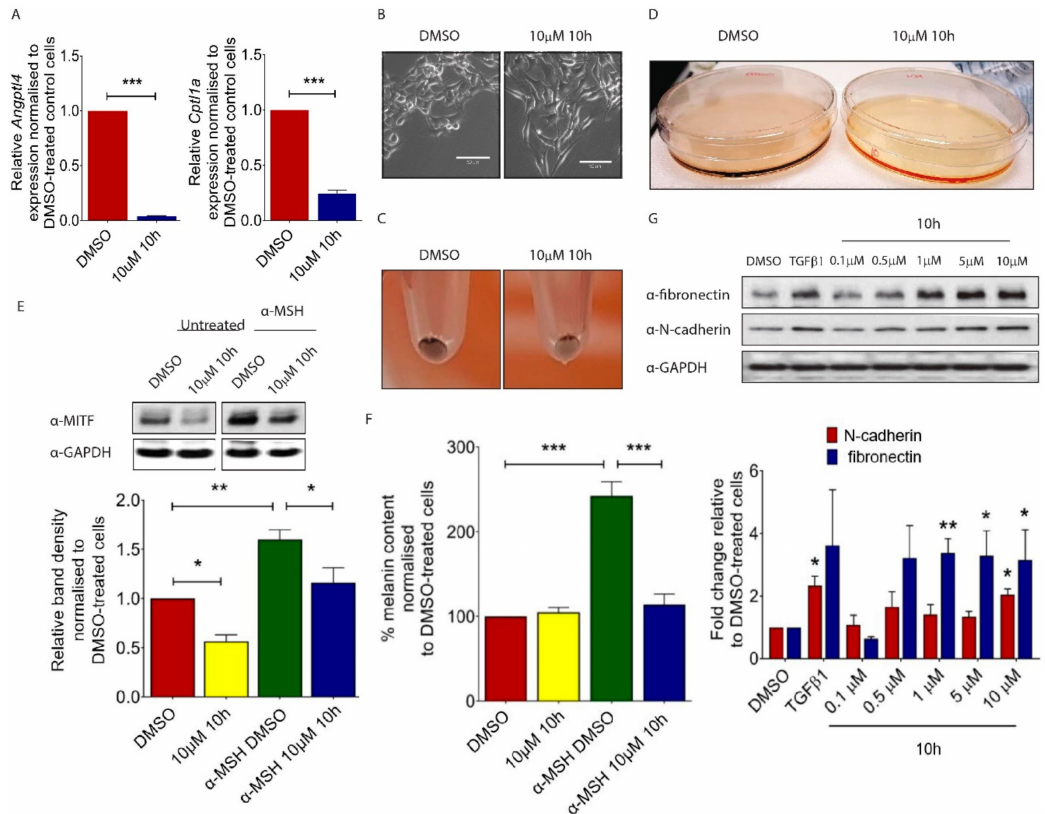
Figure 1. Effect of 10h on B16/F10 mouse melanoma cells. ( A ) Angptl4 and Cpt1 gene expression measured using real-time quantitative PCR analysis. ( B ) Morphology of B16/F10 cells after treatment with 10 µ M of 10h in 5% serum supplemented DMEM compared to 0.05% DMSO-treated control cells. Scale bar: 50 µ m. Representative picture of trypsinized B16/F10 cell pellets ( C ) and conditioned medium ( D ) after 72 h treatment with 10 µ M of 10h. ( E ) Representative images and quantitative analysis of western blot for MITF in α -MSH and/or 10h-treated B16/F10 melanoma cells. ( F ) Percentage of melanin content in α -MSH and/or 10h-treated B16/F10 melanoma cells. ( G ) Representative images and quantitative analysis of western blot for fibronectin, N-cadherin, and GAPDH in 10h-treated B16/F10 cells. Data are presented as mean ± s.e.m of three independent experiments. Statistical analysis was performed using one-way ANOVA followed by Turkey’s post hoc analysis or two-tailed, unpaired student’s t -test; * p < 0.05, ** p < 0.01, *** p <